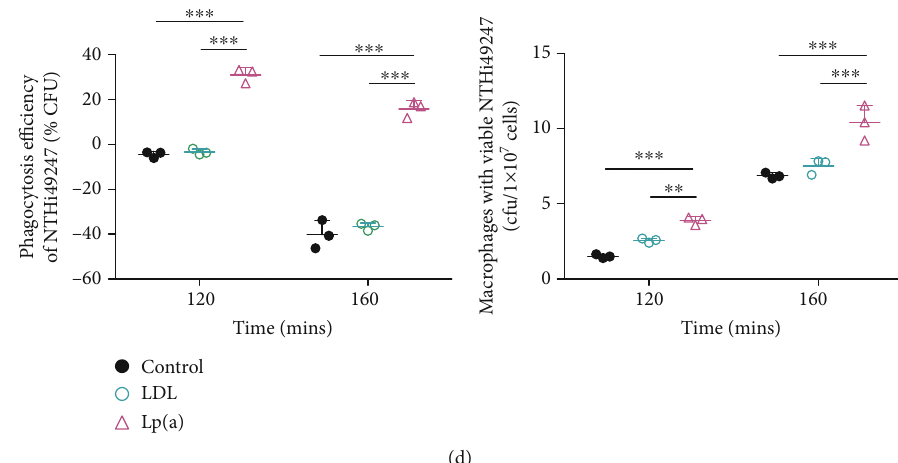
Figure 3: Lp(a) opsonized NTHi for phagocytosis by U937 macrophages. (a, b) The phagocytosis of NTHi49247, NTHi49766, E.coli BL21, and E.coli JM109 by U937 macrophages was estimated by CFU counts and RFI measurements after a (a) 120 or (b) 160min incubation. E ffi ciency of phagocytosis is indicated with the following formula: ð A − B Þ / A , where A is the value of bacteria with or without treatment after the indicated incubation period in culture and B is the value of bacteria with the same treatment and incubation period as that of A but with coincubation with macrophages. The relative phagocytosis e ffi ciency of protein-treated bacteria was calculated by using the protein-free control group in the same experiment as a benchmark. Raw fl uorescence measurements were corrected using a bu ff er blank. Each experiment was conducted at least in triplicate. Data are shown as means ± SD . Statistical signi fi cance of samples with bacteria+Lp(a) versus bacteria+LDL was determined by two-way ANOVA with the Bonferroni post hoc test ( ∗∗ P < 0 : 01 , ∗∗∗ P < 0 : 001 ). (a, b) The CFU and RFI values at two time points of the macrophages phagocyting Lp(a)-treated NTHi49247 and NTHi49766 were signi fi cantly higher than those of the cells phagocyting LDL-treated microbes. And for two strains of E.coli , there was no signi fi cant di ff erence in CFU and RFI values of the cells engul fi ng Lp(a)-treated and LDL-treated microbes. (c) Change of phagocytosis e ffi ciency of NTHi49247 in the presence of rKIV , LDL, BSA. No signi fi cant di ff erences among those three treatments. (d) Lp(a) promotes the 10 internalization of NTHi49247 into U937 macrophages. Along with the signi fi cant increased phagocytosis of NTHi49247-Lp(a) by U937 macrophages, the intracellular viable NTHi49247 in U937 macrophages is signi fi cantly increased. Statistical signi fi cance of samples with bacteria+Lp(a) or LDL versus bacteria alone was calculated by two-way ANOVA with the Bonferroni post hoc test ( ∗∗ P < 0 : 01 , ∗∗∗ P < 0 : 001